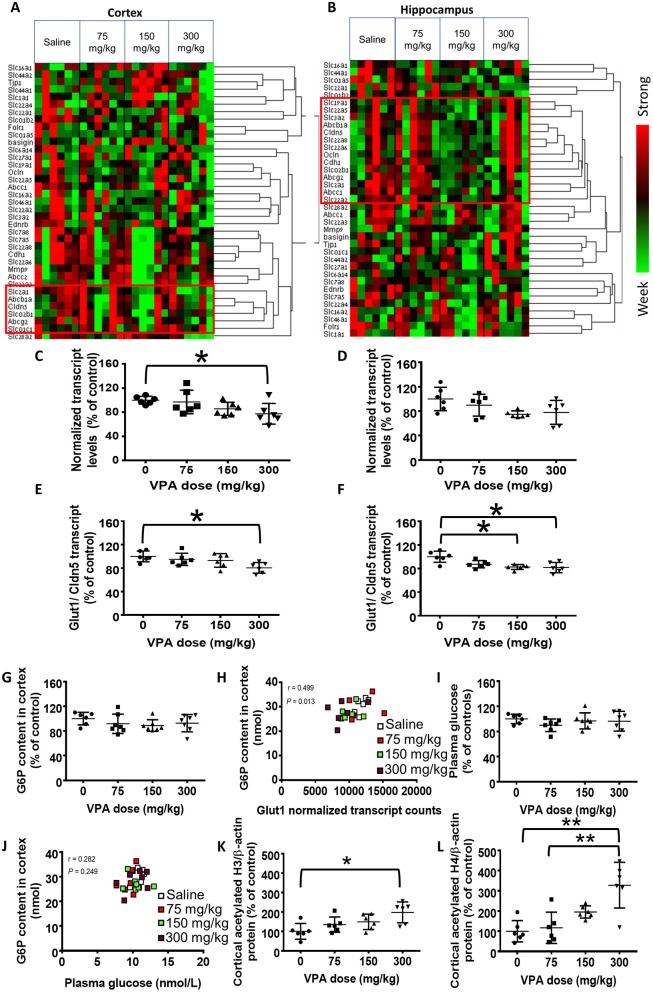
Effect of VPA on cerebral gene expression. (A,B) Hierarchically clustered normalized nCounter heatmaps of carriers and BBB components mRNA levels at the (A) cortex and (B) hippocampus. For each gene, expression was normalized to the geometrical mean of three housekeeping genes and the negative and positive technical controls. Each vertical column represents one animal belonging to the treatment group indicated in the upper panel. Each horizontal lane represents the normalized mRNA counts for one gene. The colors represent the expression of each gene among the different treated animals (red and green represent strong and weak expression, respectively). Red frames mark the genes which were clustered with Glut1. (C,D) nCounter gene expression analysis of cortical (C) and hippocampal (D)
Glut1 mRNA levels. (E,F) Cortical (E) and hippocampal (F)
Glut1 mRNA normalized to the BBB marker Cldn5. (G) Cortical G6P levels (nmol). (H) Correlation between cortical G6P levels and Glut1 transcript counts. (I) Plasma glucose concentration (mM). (J) Correlation between cortical G6P and plasma glucose. (K,L) Histone acetylation in VPA-treated rats. (K) Cortical histone H3 acetylation. (L) Cortical histone H4 acetylation. Values in C–G,I,K, and L are means with SD and presented as percent of control; *P < 0.05, **P < 0.01, N = 6–7/group.